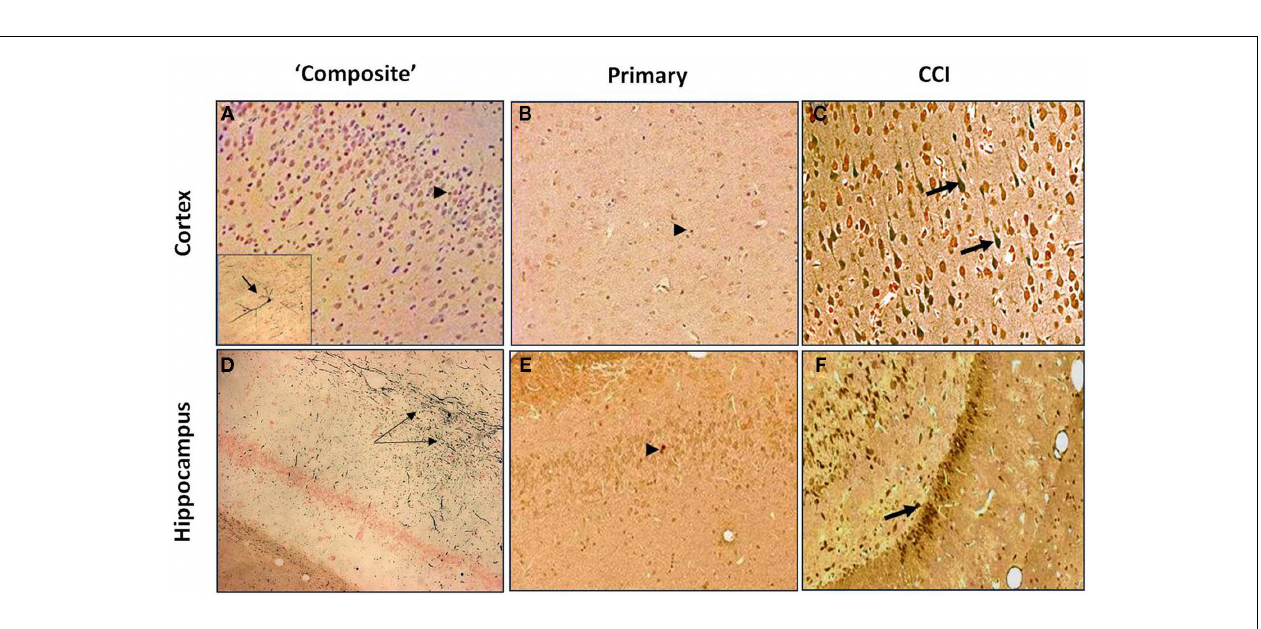
silver accumulation in the cells of non-neuronal origin. Arrows indicate diffuse silver accumulation in neurons. Figure 3A inset: a very rare accumulation of silver in a cortical neuron. Please see Section “Materials and Methods” for